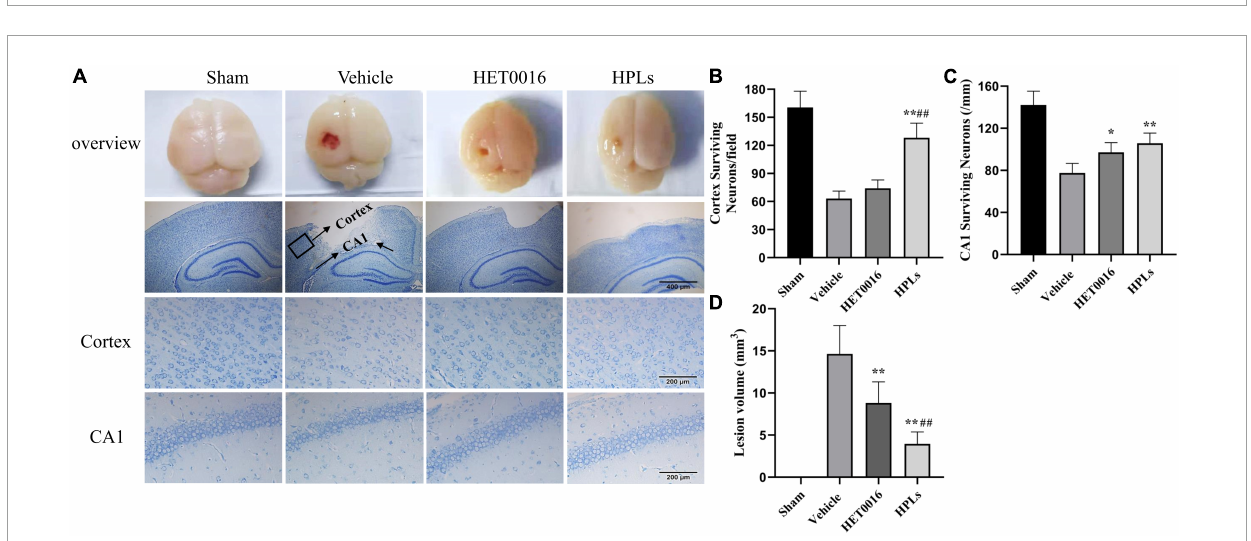
FIGURE5 HPLs reduced the lesion volume and neuronal degeneration after TBI. (A) Brain defects of rats (magnification of region: 200 times) and Nissl stain in each group (magnification of region: 400 times). Quantitative analysis of the Nissl positive cells in the cortex (B) and hippocampus (C) on the injured side. (D) Quantitative analysis of brain injury volume in each group. Values were mean ± SD. * p < 0.05, ** p < 0.01 versus Vehicle, # p < 0.05, ## p < 0.01 versus HET0016, n = 6 in each